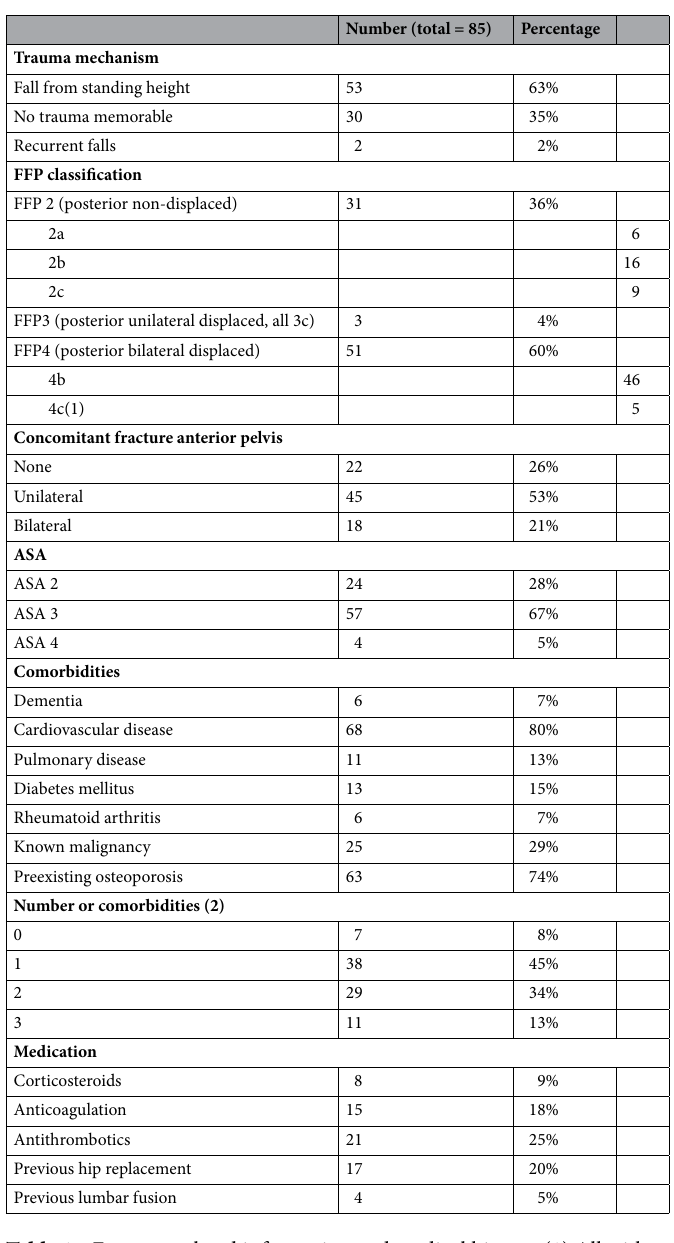
Table 1. Fracture-related information and medical history. (1) All with sacral fracture and contralateral crescent fracture of the ilium. (2) Counting: Dementia, cerebrovascular disease, pulmonary disease, diabetes mellitus, rheumatoid arthritis, known